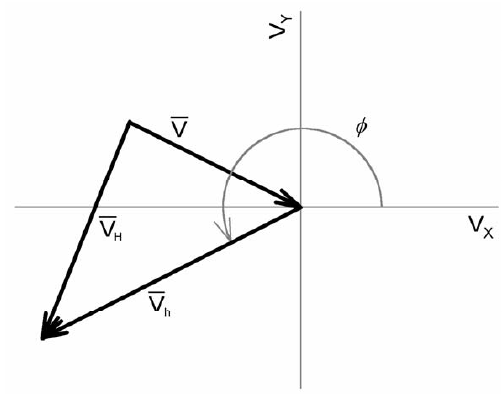
Fig. 7. Translation of coordinates so as to observe more clearly wind rotation in the low atmosphere. ¯ V is the global average, ¯ V H , the hourly average and ¯ V h the difference between